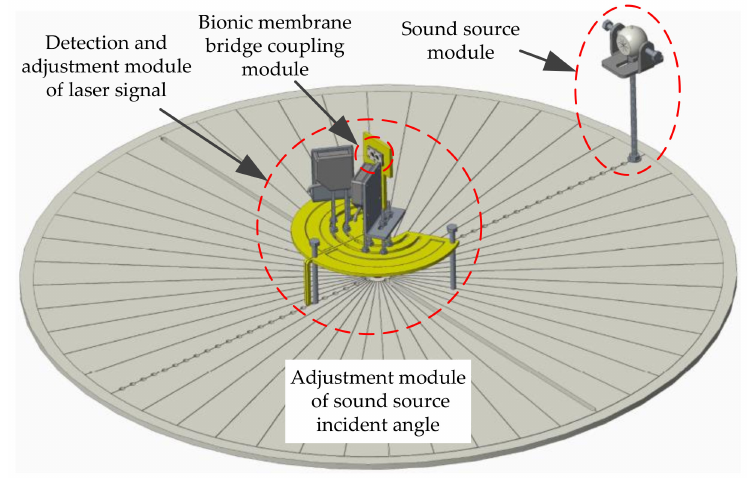
Figure 12. The laser detection system for sound source